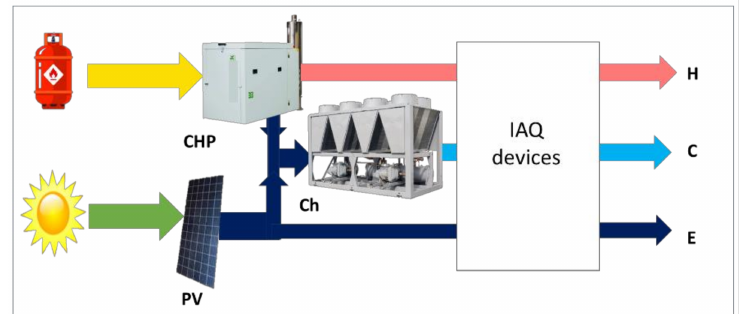
Figure 3. Energy generation facility scheme.